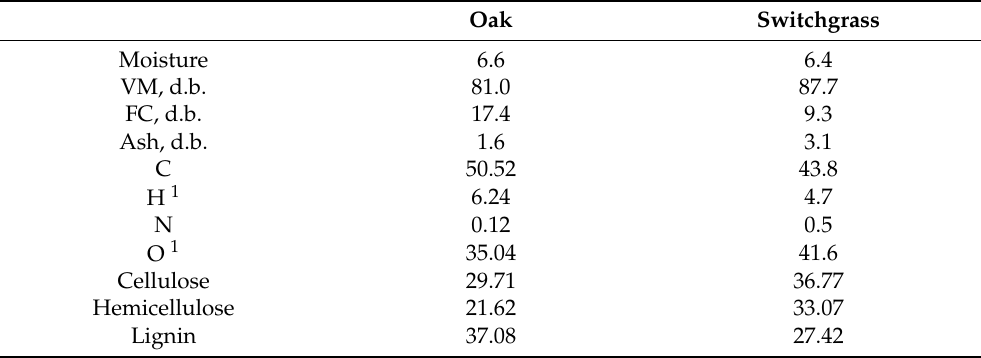
Table 1. Proximate, ultimate and biochemical analysis (wt %) of oak and switchgrass biomasses used in this study.